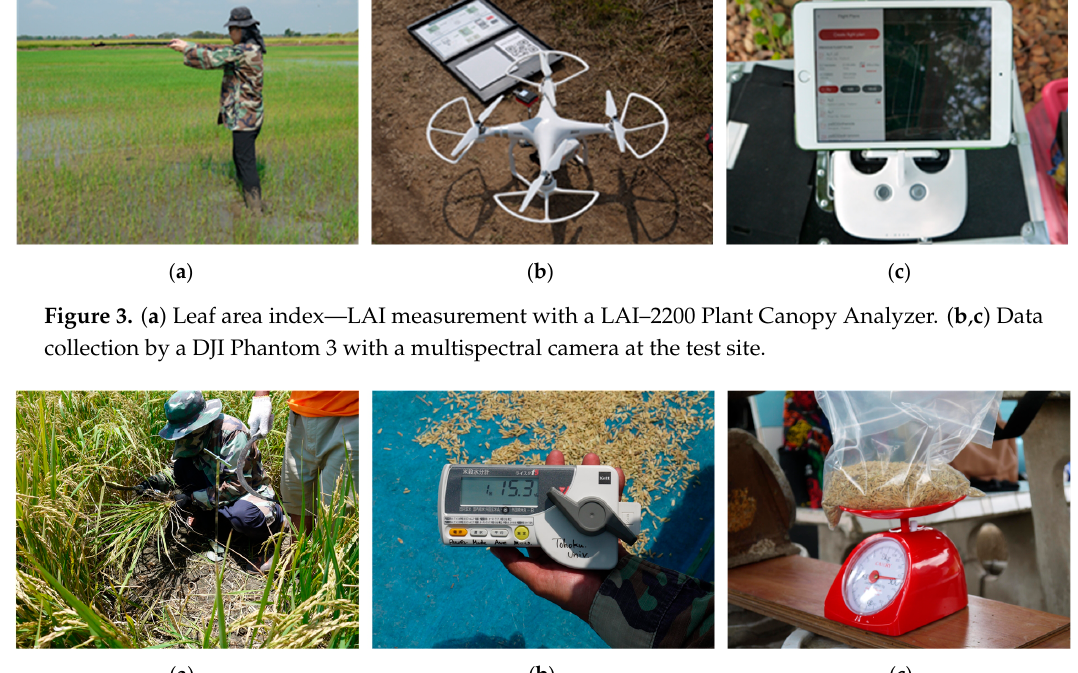
Table 1. Field data collections in